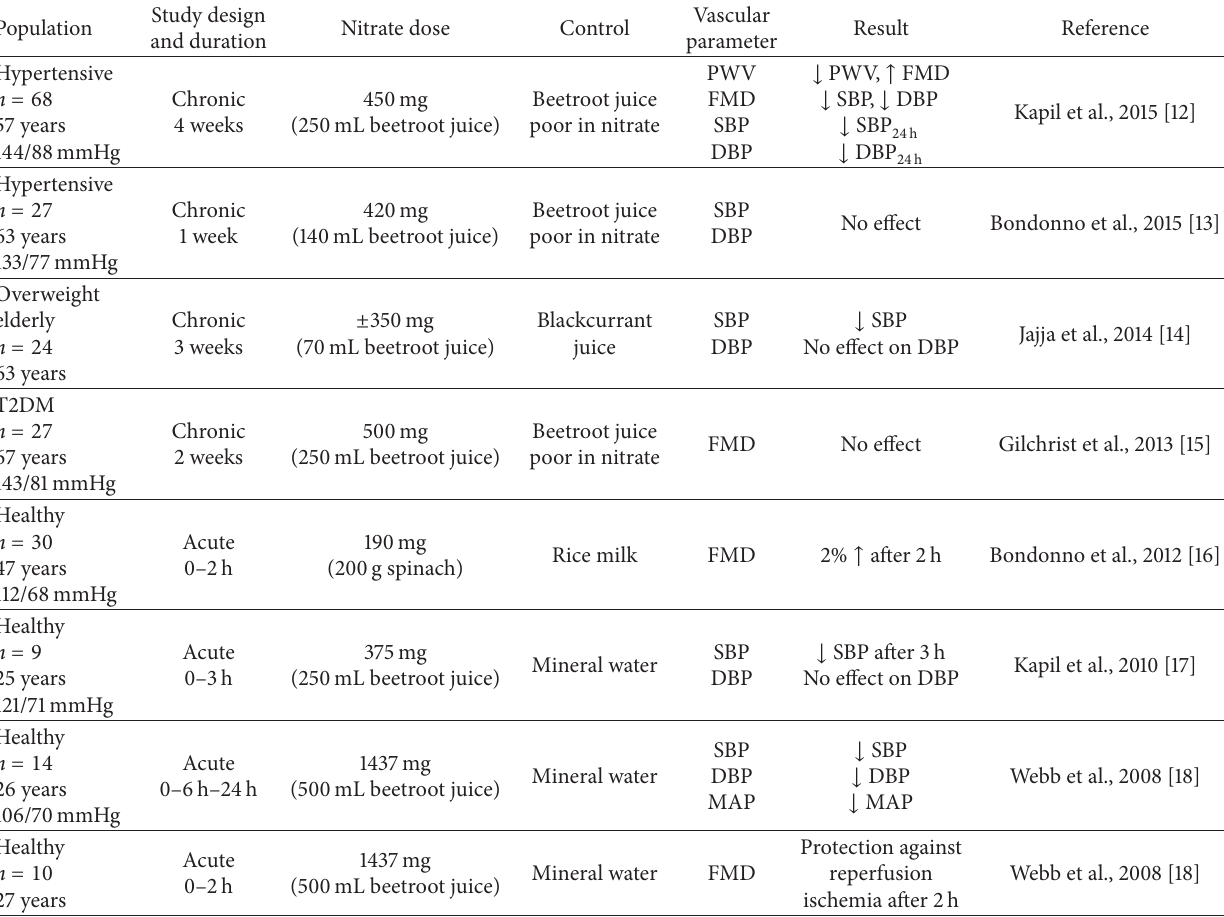
Table 2: Clinical trials evaluating the effects of dietary inorganic nitrate on cardiovascular